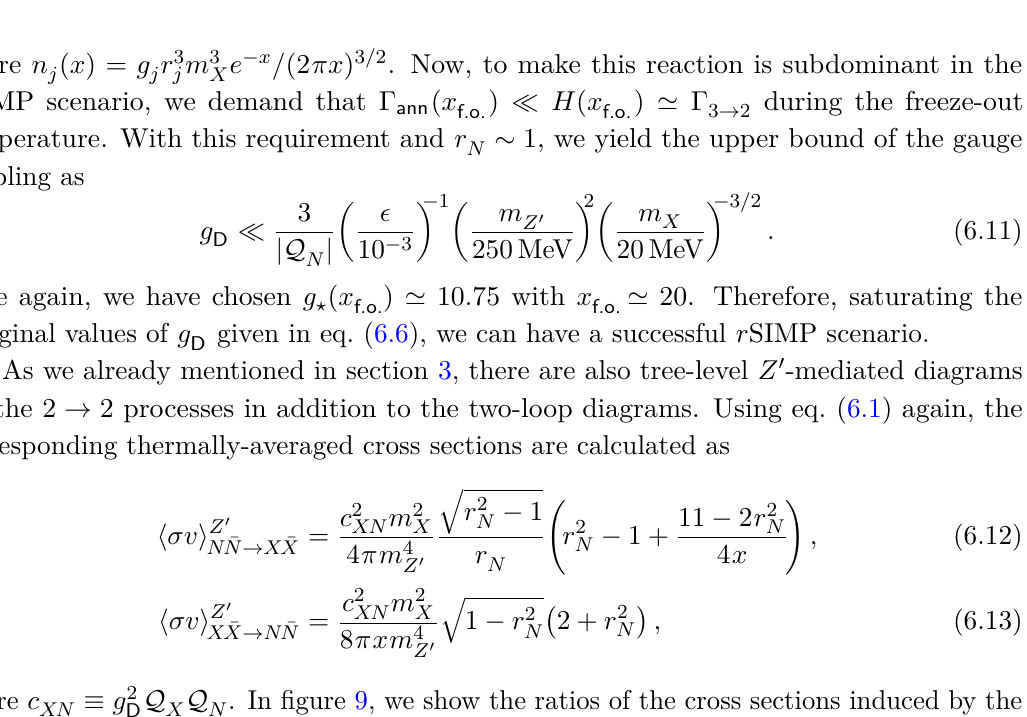
Figure 9 . The R and R as functions of x with the parameter inputs given in N ¯ N → X ¯ X X ¯ X → N ¯ N figures 7 and 8. Here we have fixed the g to the minimal value of eq. (6.6) with (cid:15) = 10 − 3 and D m = 250 MeV, and 3 Q = 2 Q for making these Z 0 X N